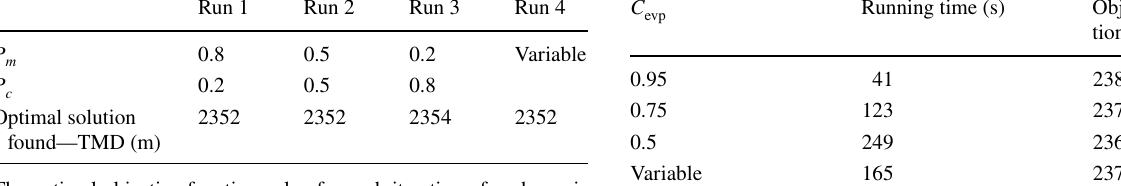
The optimal objective function value for each iteration of each run is illustrated as trends in Fig. 6 (Case